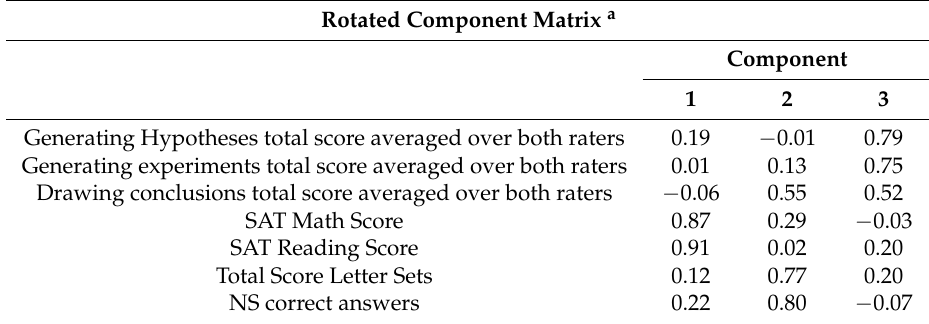
Table 13. Principal component analyses in Study 2 with SAT and analytical ability